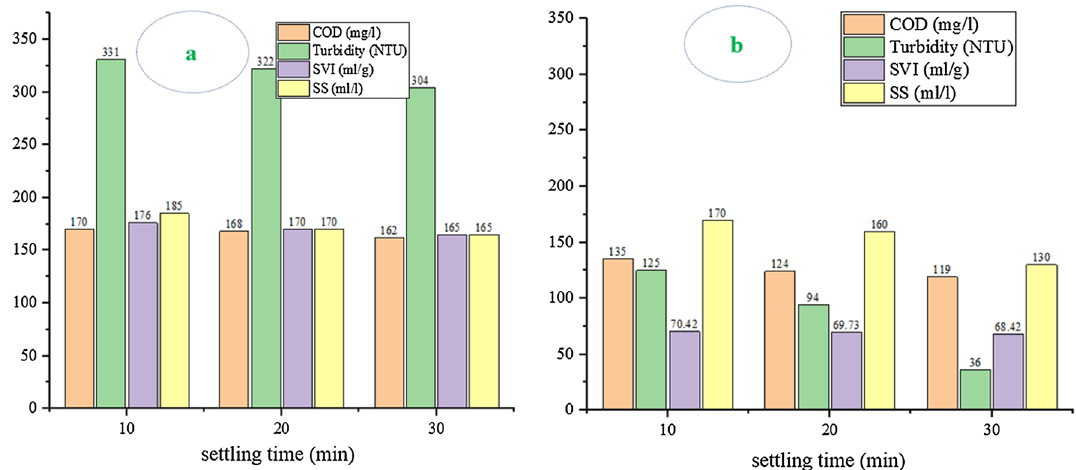
Fig. 4 Effect of settling time on COD, turbidity, SVI, and SS. a ozonation = 15 min and b non-ozonztion. (Polymer concentration = 30 gr/dry SL, coagulation time = 30 s, flocculation time = 20 min)